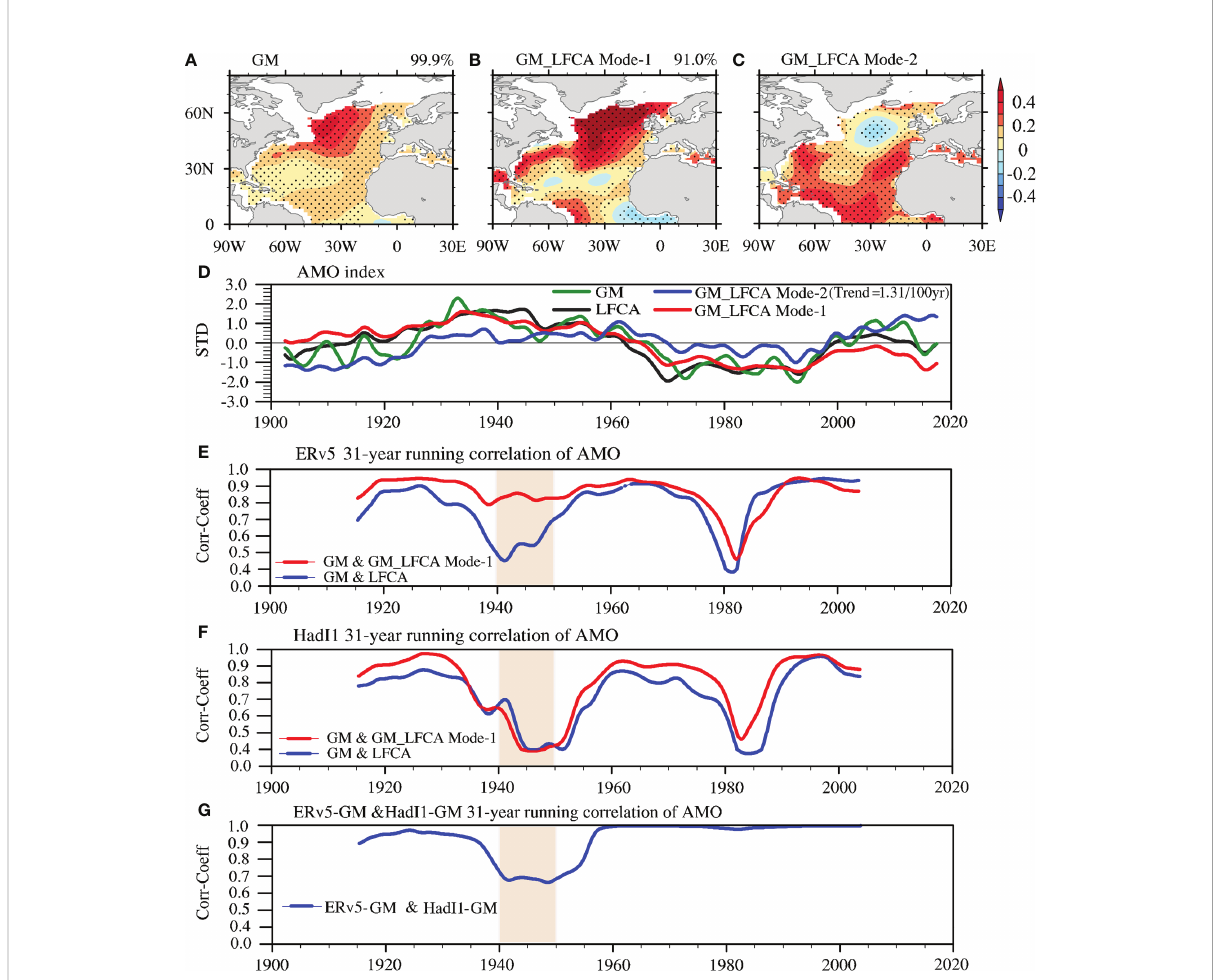
FIGURE 8 The AMO patterns (A) using the de fi nition of subtracting the global mean SST (GM) based on TS2006 and (B) extracted by LFCA before removing the global mean SST (GM_LFCA Mode-1). Dots indicate where values pass the 95% signi fi cance level, and the AMO CI is given in the top right of the fi gure. (C) Second leading GM_LFCA Mode (GM_LFCA Mode-2). (D) AMO indices derived from LFCA, GM, GM_LFCA Mode-1 and GM_LFCA Mode-2 based on ERv5 SST data. (E) Similar to Figure 2C but for different approaches based on ERv5. (F) Similar to (E) but based on HadI1. (G) Similar to (E) but using the TS2006 approach based on ERv5 and